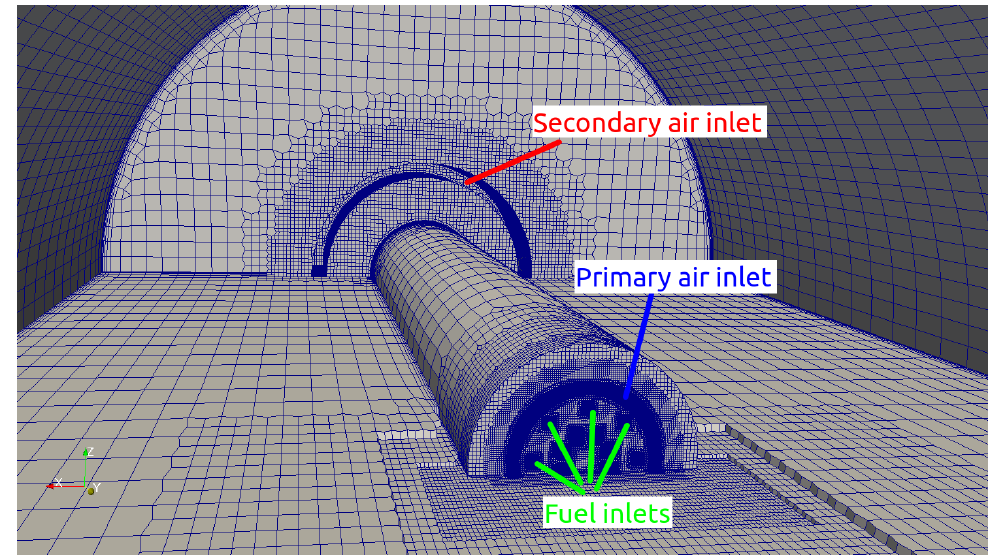
Figure 3. Mesh inside of the kiln with a modified (annular) secondary air inlet. The figures show the multi-nozzle burner and cooling slot in the foreground, the burner pipe and the secondary air inlet channel in the background. Only the lower half of the kiln’s internal volume grid is visible (some unclipped cells appear out of the plane) to show the refinement regions. For increased visibility, a coarse mesh is shown here. Ref. [17] Reproduced with permission from